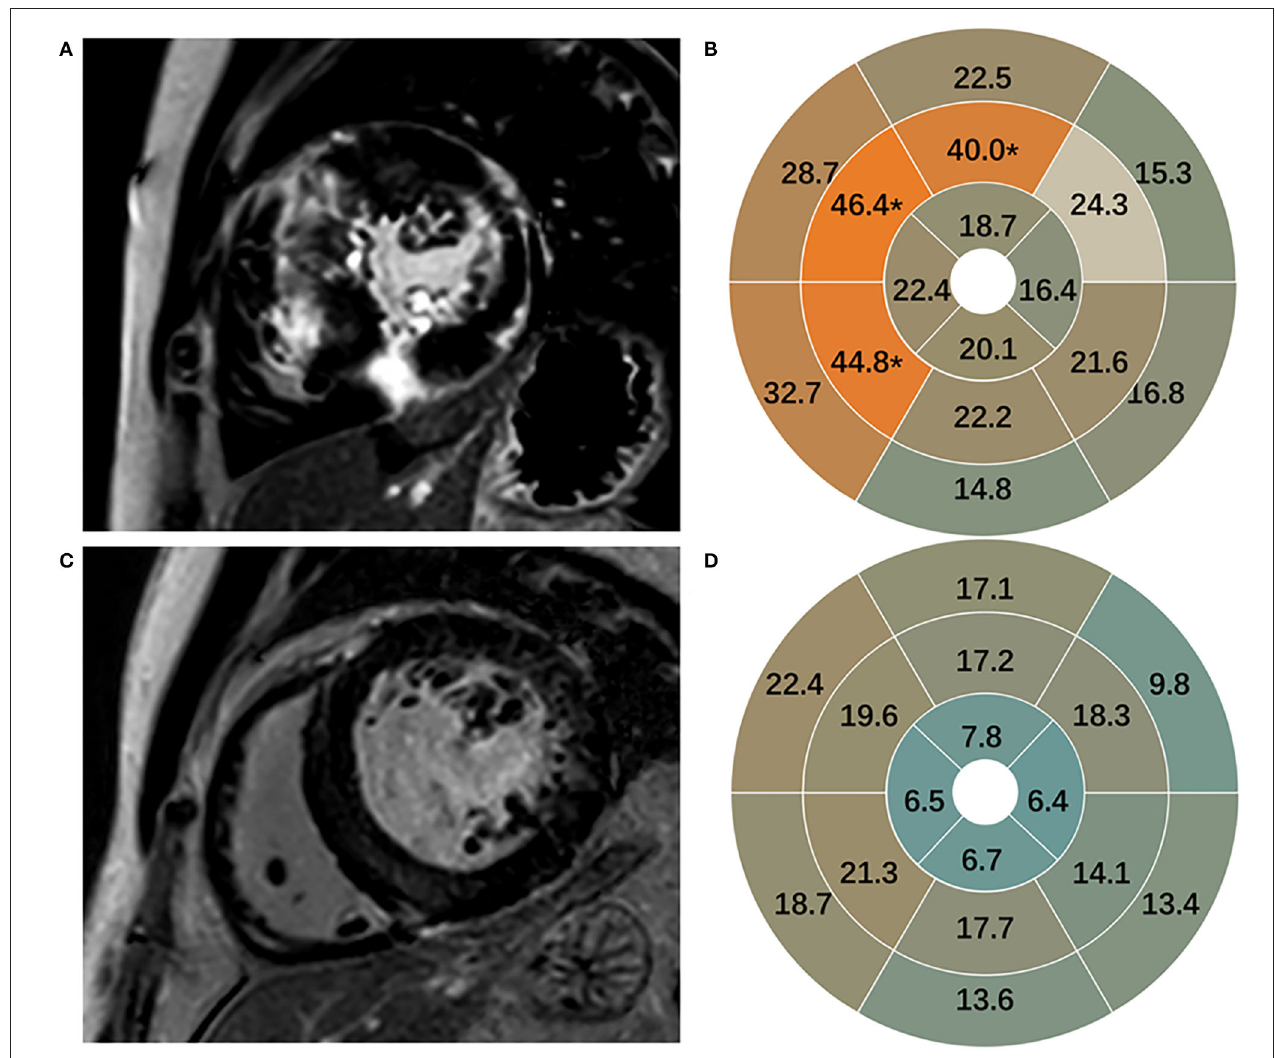
FIGURE 2 | Representative images of LGE in HCM (A) and HHD (C) . LGE in 16 segments in HCM (B) and HHD (D) . LGE, late gadolinium enhancement; HCM, hypertrophic cardiomyopathy; HHD, hypertensive heart